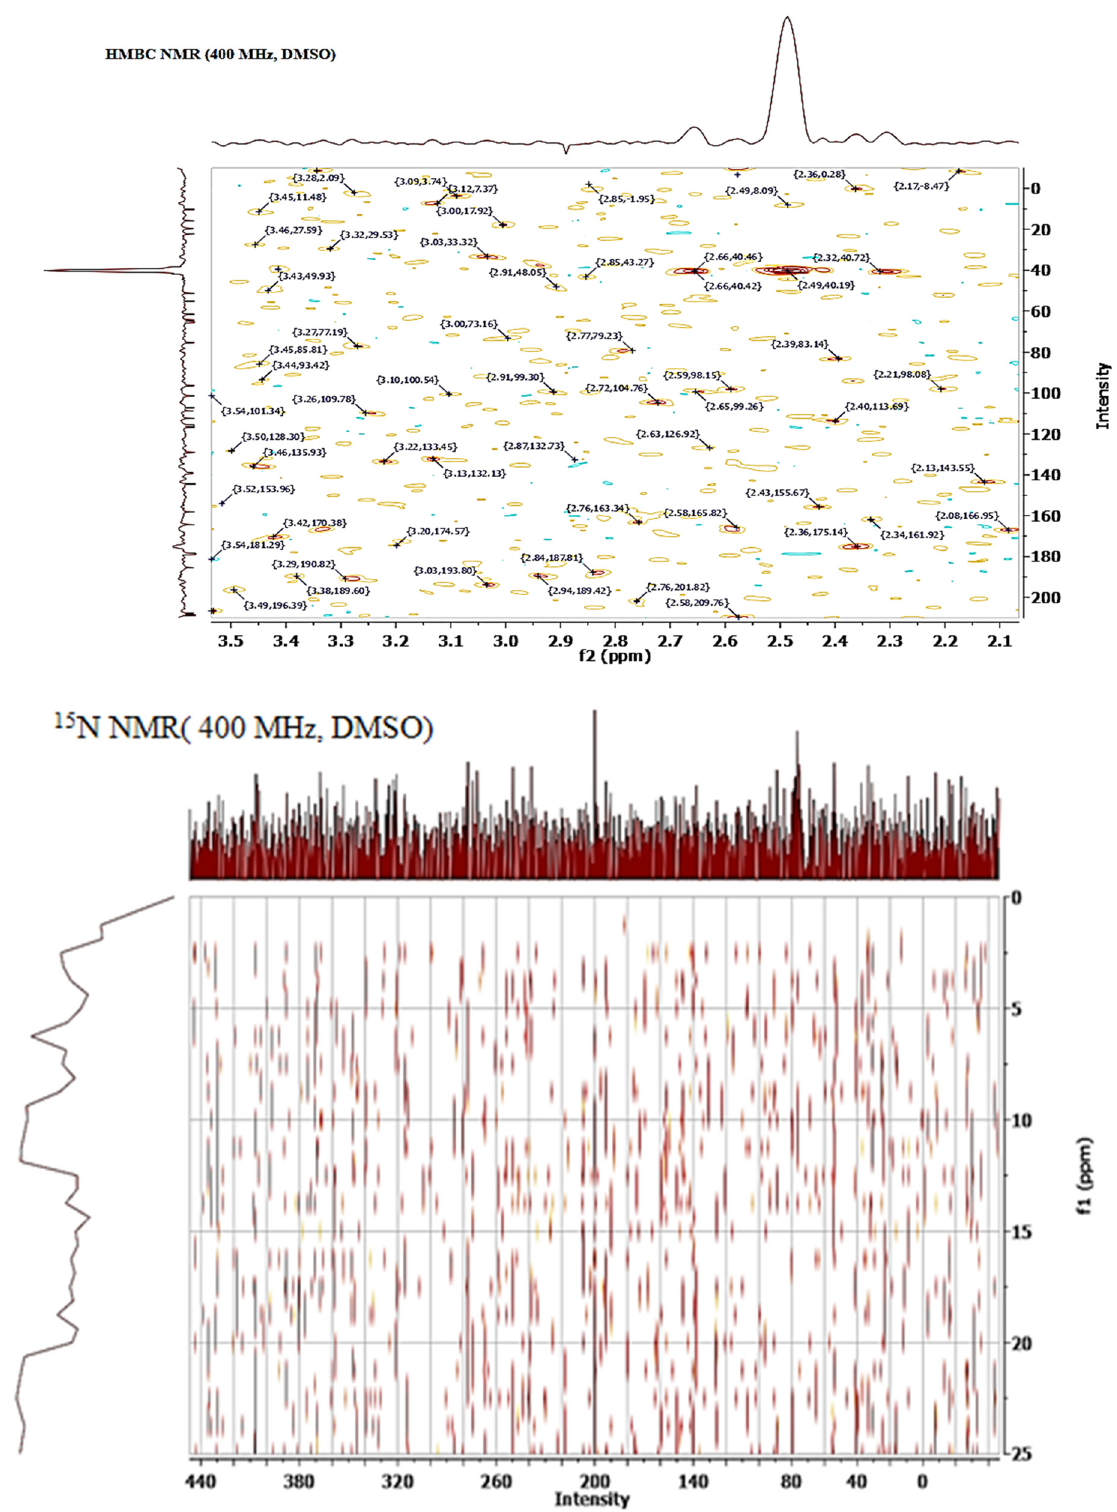
Figure 3: 1D and 2D NMR spectrum of pumpkin pectin extracted from pulp ( a ) 1 H NMR, ( b ) 13 C NMR, ( c ) 15 N NMR, and ( d ) HMBC